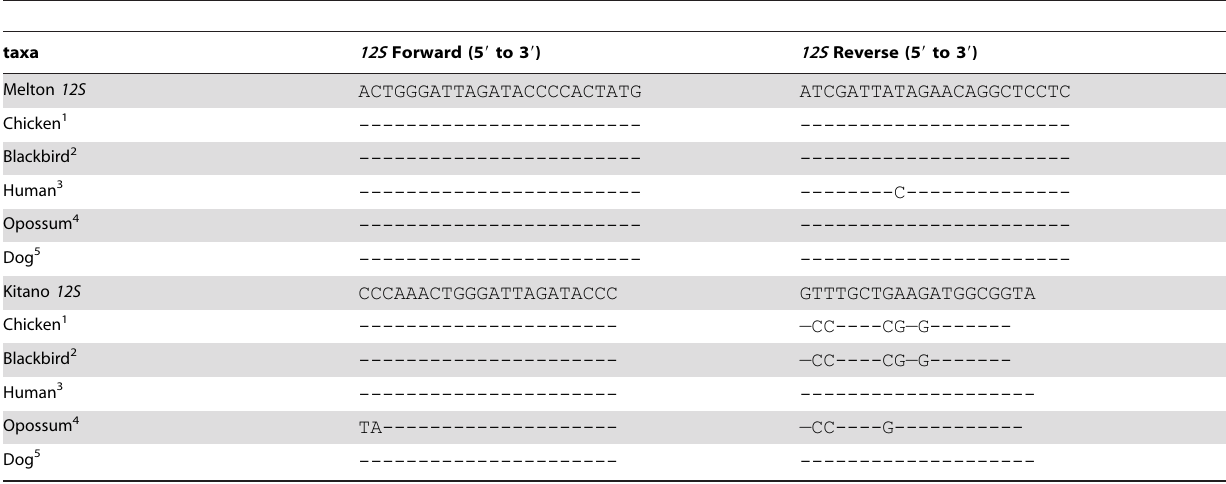
Table 3. Match between primers used in the cloning assays to identify blood meal sources of Triatoma guasayana and the taxa detected, showing that the Melton primers are a better match than the Kitano